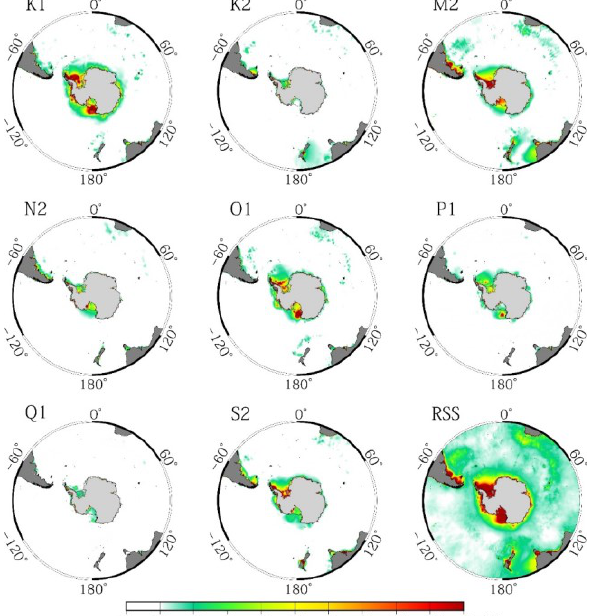
Figure 2. The RMS and RSS for eight constituents between the six selected models. The spatial patterns of all constituents are similar. For semi-diurnal tides, the largest discrepancies are located under big ice shelves, and for the diurnal tides, the largest errors are in the open continental shelf areas.